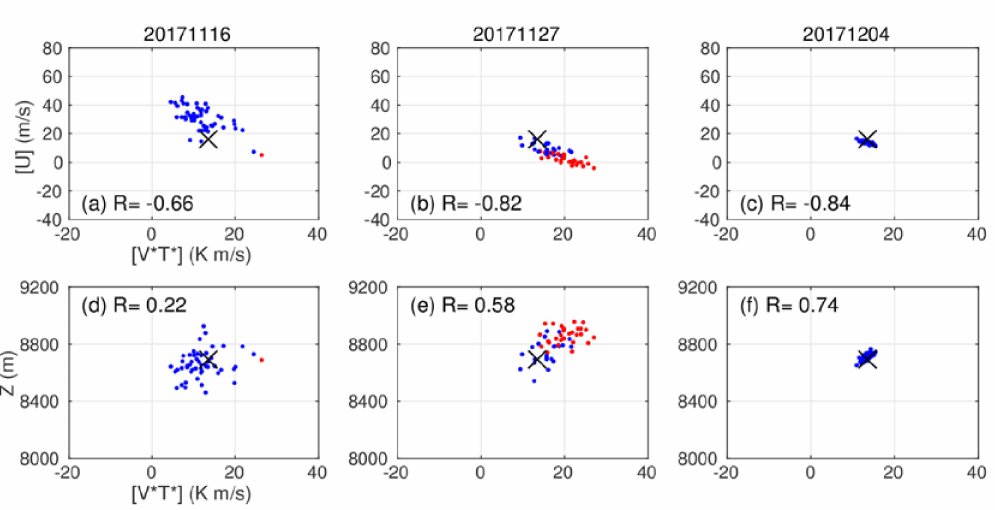
Figure 5. ( a – c ) Scatter plots between the waves 1–3 heat flux over 40–90 ◦ N, 100 hPa, and the zonal mean zonal wind at 60 ◦ N, 10 hPa for all members in the MSSW ( b ) and non-MSSW ( a , c ) ensembles for the first cluster. The zonal mean zonal wind is averaged for 5 days around RD. The heat flux is averaged from RD-6 to RD. The forecast data are plotted by dots in di ff erent colors, with a black cross for the JRA-55 data. Red dots are for MSSW members, blue dots for non-MSSW members, and black dots for the rest (the rest includes no member for these initial dates). The initial dates are denoted above the panels. The number in each panel denotes the correlation coe ffi cient for all ensemble members. Panels ( d – f ) are similar, but use the 300 hPa geopotential height averaged over a region of 65 ± 10 ◦ N, 305 ± 15 ◦ E from RD-6 to RD, instead of the zonal